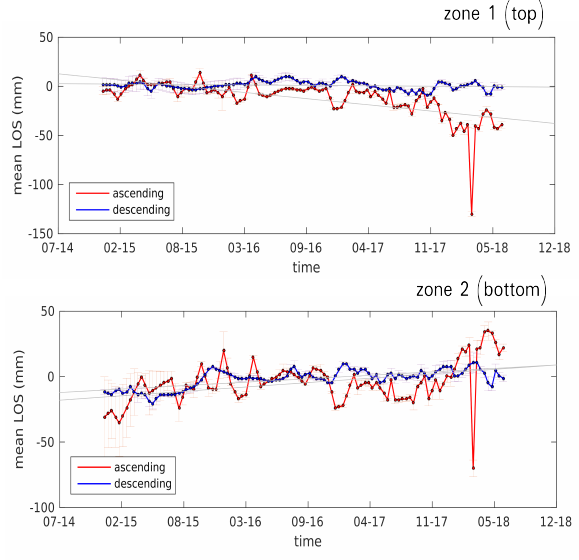
Figure 5. The mean LOS InSAR result both the ascending and the descending data in the Puncak Pass